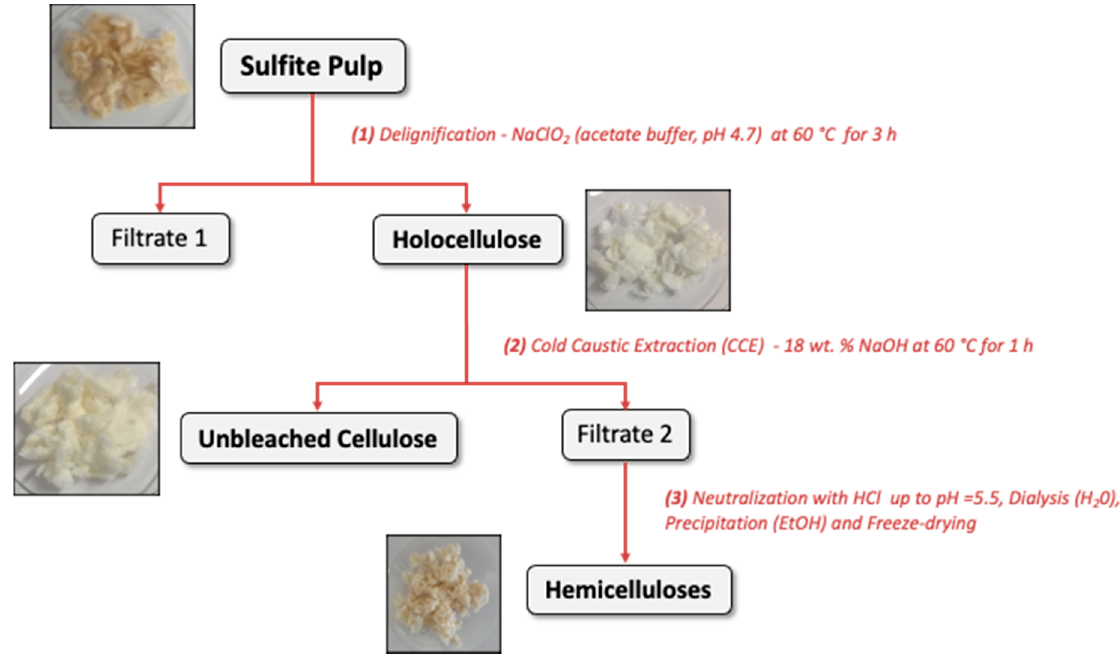
Figure 1. Procedure for hemicellulose extraction from a sulfite